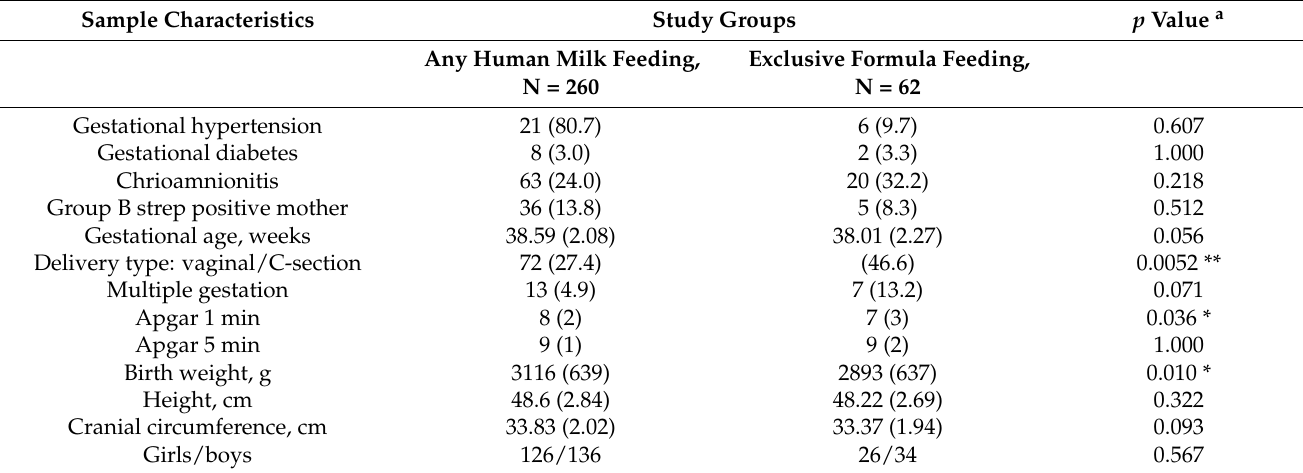
Table 1. Background information.